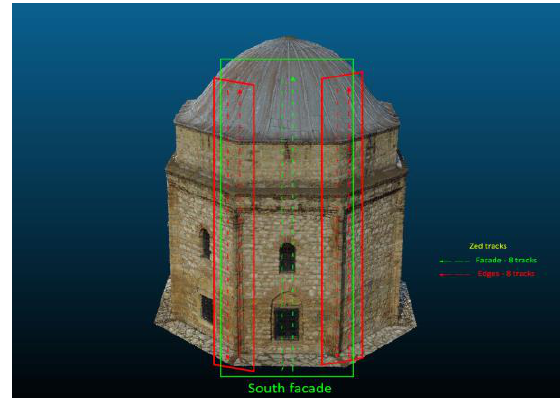
Figure 4. The flight path of ZED camera for every facade. Green trace indicates the double path (upwards and downwards) for the central part of the facade, while the red ones are the flights executed to capture the edges.